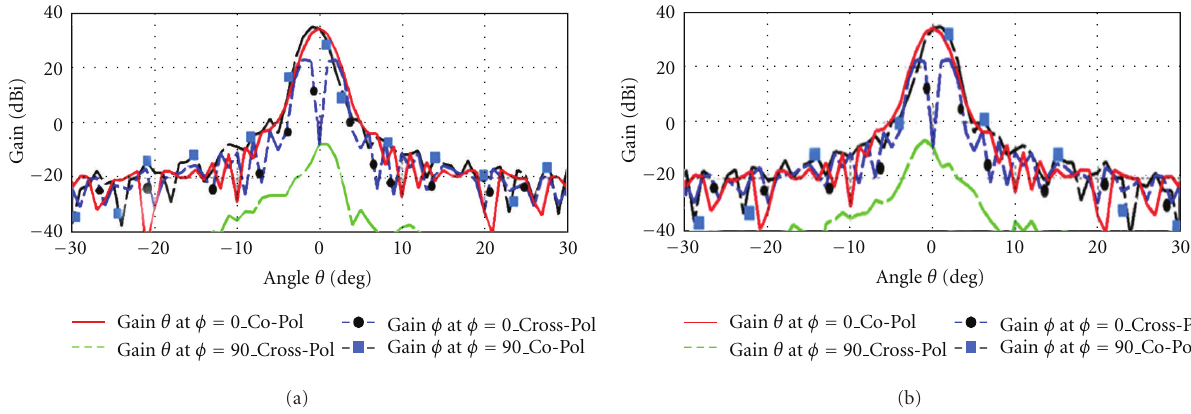
Figure 9: Reflector antenna radiation patterns at 7.73 GHz with the feedhorn mode combination of TE 11 (50%) + TE 21 (50%). Mode for the fixed phase values of (a) +90 ◦ and (b) − 90 ◦ .